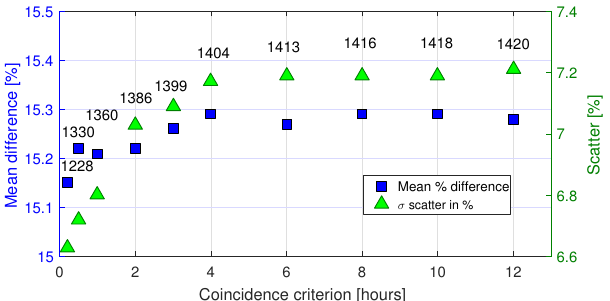
Figure 6. The variation in mean percent difference and scatter (1 standard deviation) between the water vapour total column of the 125HR and SPM at the Ridge Lab comparison as a function of the temporal coincidence criterion. The resulting number of coin- cidences at each temporal coincidence criterion is labelled next to each data